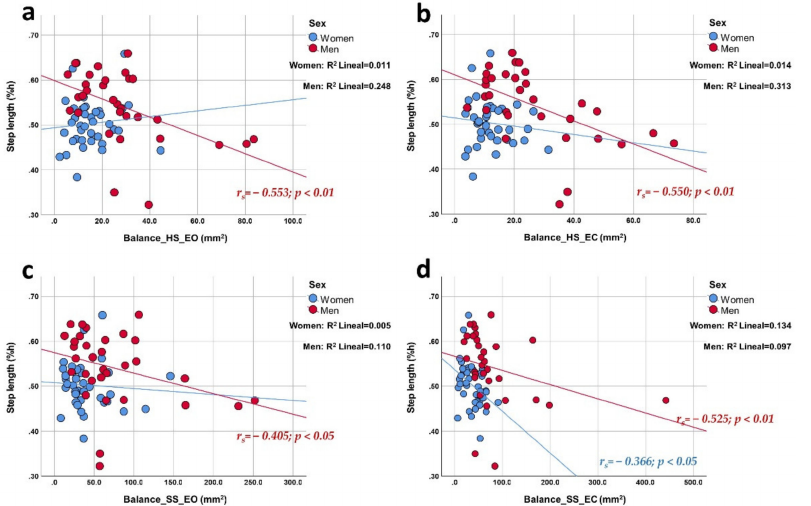
Figure 2. Correlation plots of step length compared to balance area in each of the tests. Each image shows the correlations obtained distributed by sex. The upper part of the figure shows the results for a hard surface with eyes open (panel ( a ); linear R 2 women: 1.1%; men: 24.8%) and closed eyes (panel ( b ); linear R 2 women: 1.4%; men: 31.3%); the lower part shows the results for a soft surface with open eyes (panel ( c ); linear R 2 women: 0.5%; men: 11.0%) and closed eyes (panel ( d ); linear R 2 women: 13.4%; men: 9.7%).